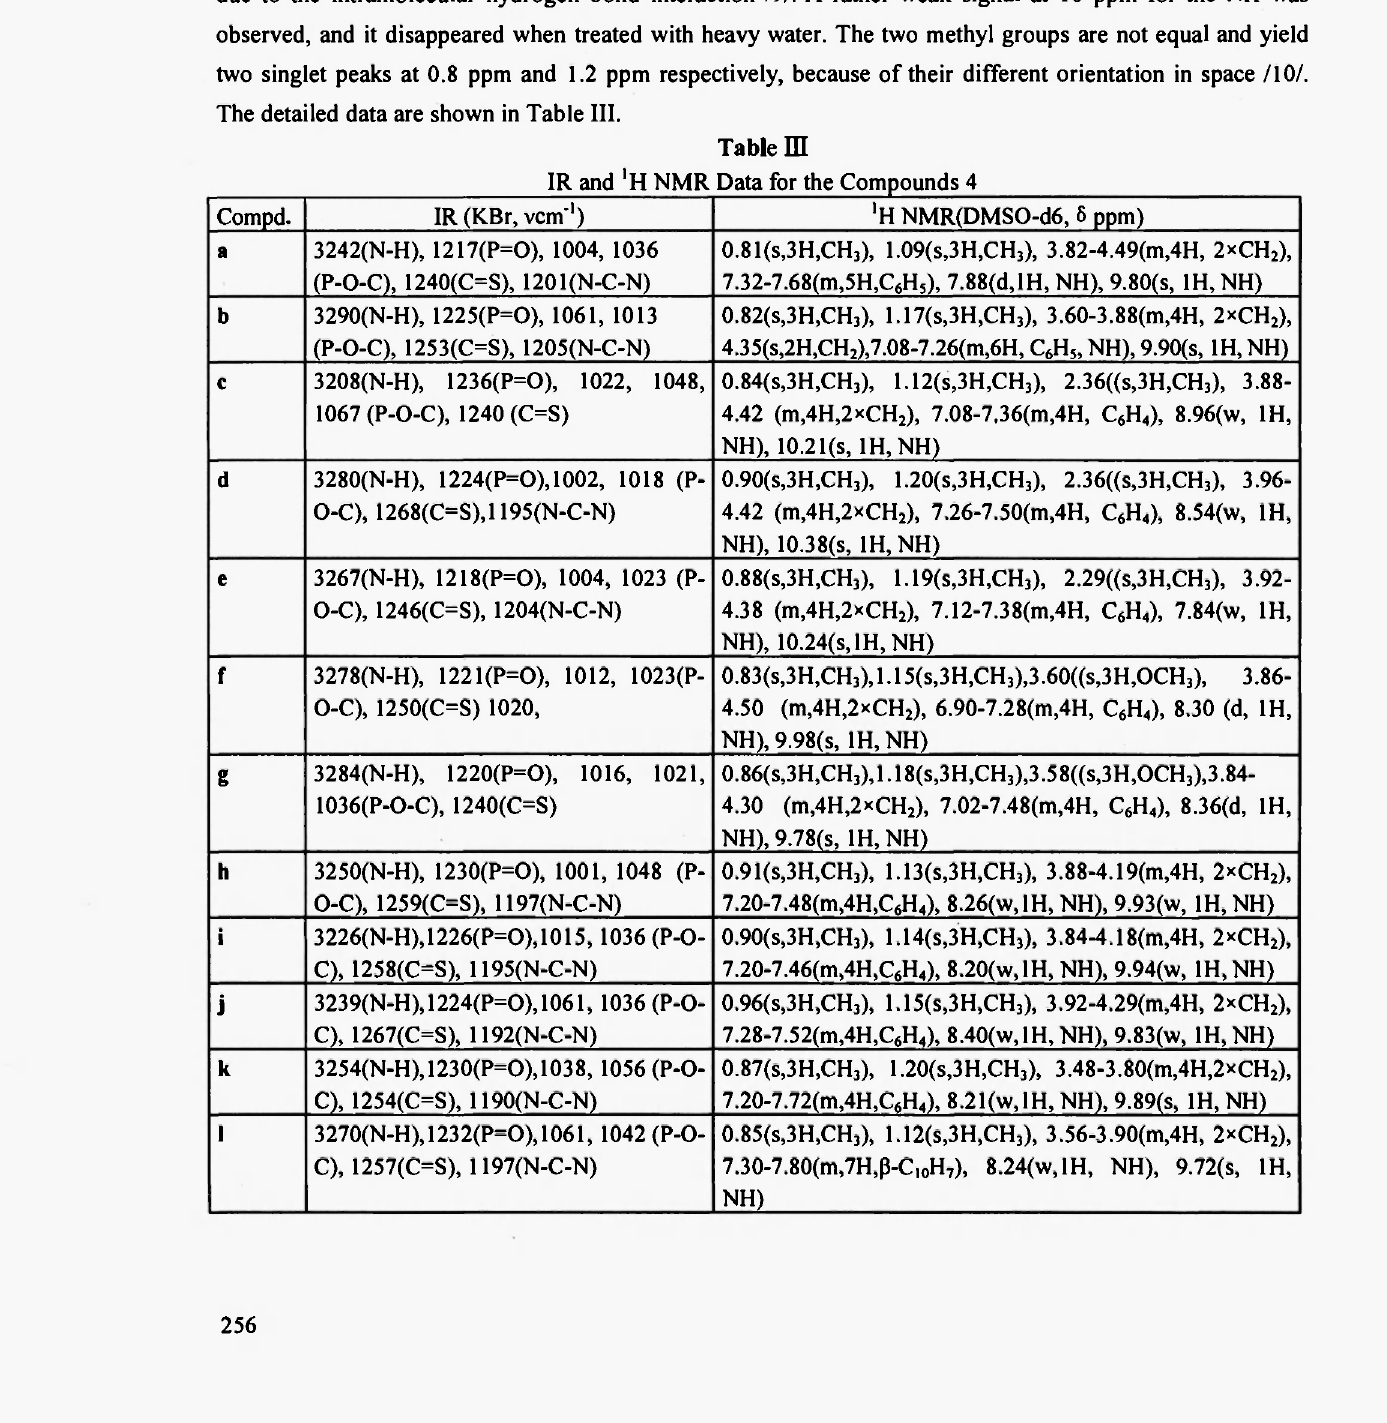
IR and 'H NMR Data for the Compounds